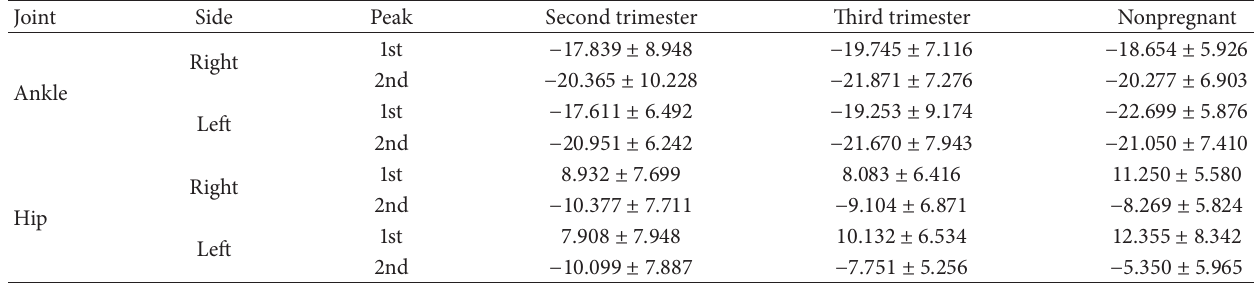
Table 4: Joint kinematic peak values (mean) of gait in the transverse plane, during the second and third trimesters of pregnancy ( 𝑁 = 22 ) and nulliparous controls ( 𝑁 = 12 ). Units (mean ± sd) are in